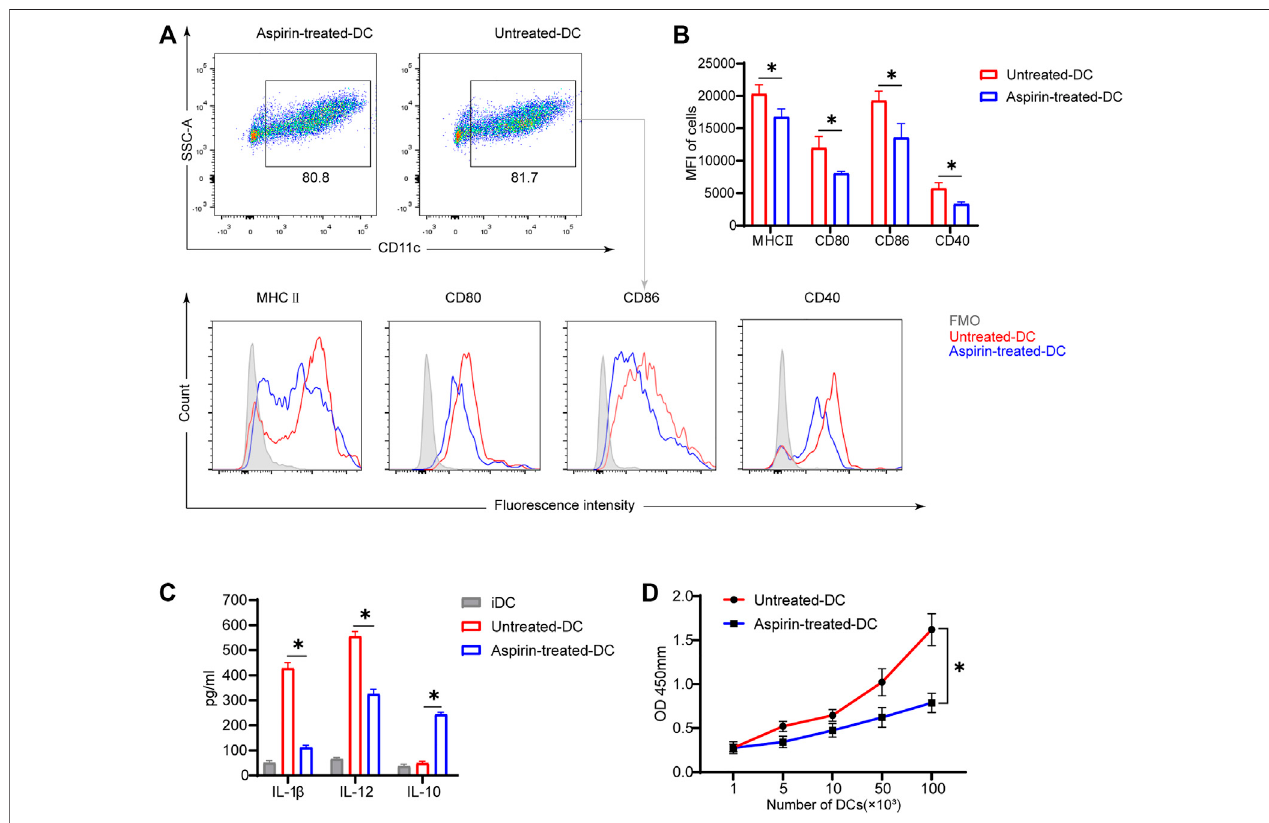
FIGURE 4 | Aspirin inhibits the maturation and function of murine bone marrow – derived dendritic cells in vitro . BMDCs were generated from bone marrow cells (from B6 mice) with granulocyte-macrophage colony-stimulating factor (GM-CSF) and interleukin (IL)-4 induction. The aspirin-treated group was supplemented with 2 mM aspirin, while the untreated group was supplemented with DMSO only. On the seventh day of culture, cells were collected and stimulated with 100 ng/ml LPS for 24 h.Afterthestimulation,cellswereharvestedanddetectedby fl owcytometry(thesamemethodas Figure3 ). (A) TheproportionofCD11c(+)dendriticcellswas displayed (top), and the expression levels of MHCII, CD80, CD86, and CD40 on DCs were shown by MFI in histograms (bottom). (B) The expression levels of MHCII, CD80, CD86, and CD40 on DCs of each group. (C) After stimulation ofDCs, the supernatant of medium in each group was collected, and the levels ofIL-1 β , IL-12, and IL-10 production were detected by ELISA. (D) The stimulated DCs ofeach group were collected and cocultured with T cells puri fi ed from spleens of BALB/c. DC-T cells weremixedindifferentproportionsforMLR.TheproliferationofTcellswasdeterminedbyCellCountingKit-8.Dataarepresentedasthemean ± SDoffourindependent experiments. * p < 0.05; MHC, major histocompatibility complex; MFI, mean fl uorescence intensity; LPS,